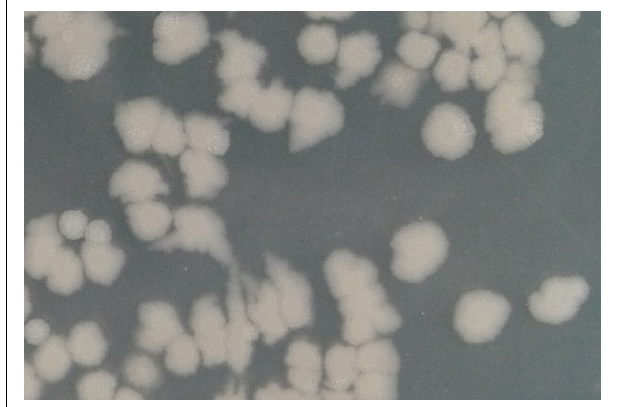
FIGURE 1 |Who is who? – a mixed culture of B. cereus group strains, namely: B. thuringiensis IEBC-T066001 (serotype entomocidus biovar subtoxicus, Canada), B. weihenstephanensis WSBC 10207 (isolated from pasteurized milk, Germany), and B. cereus F4430 (isolated from pea soup connected to a foodborne outbreak in